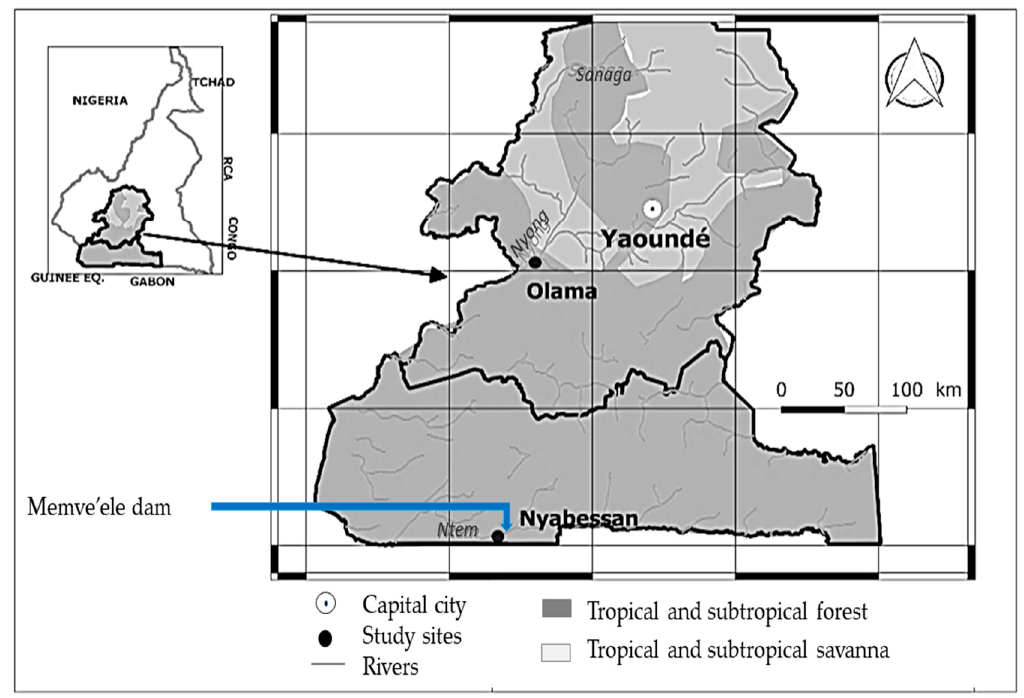
Figure 1. A map of the center and southern regions of Cameroon that show the study sites.